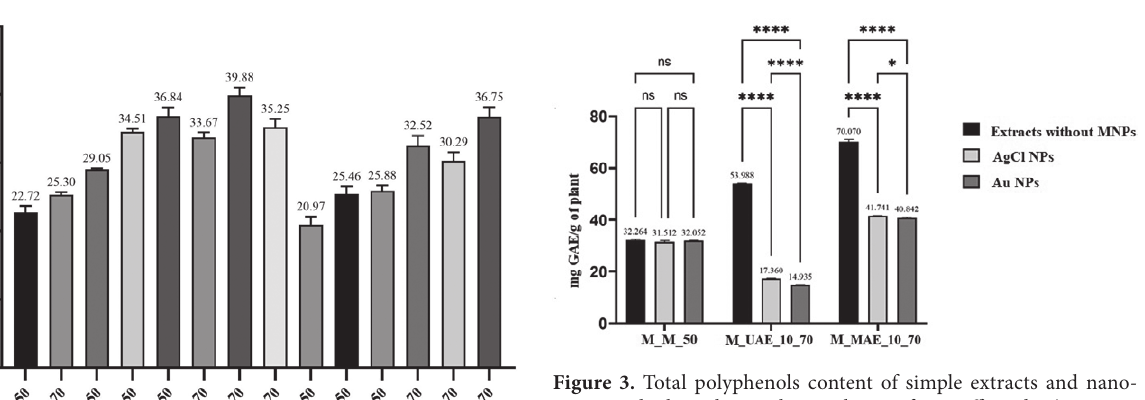
Figure 3. Total polyphenols content of simple extracts and nano- structured phytochemical complexes of M. officinalis (Data are expressed as mean ± SD values from independent triplicate experi- ments and p values were calculated by one-way ANOVA followed by Šídák’s multiple comparisons test; ****p < 0.0001; *p = 0.0472; ns p =0.1058; 0.8170; 0.2920).